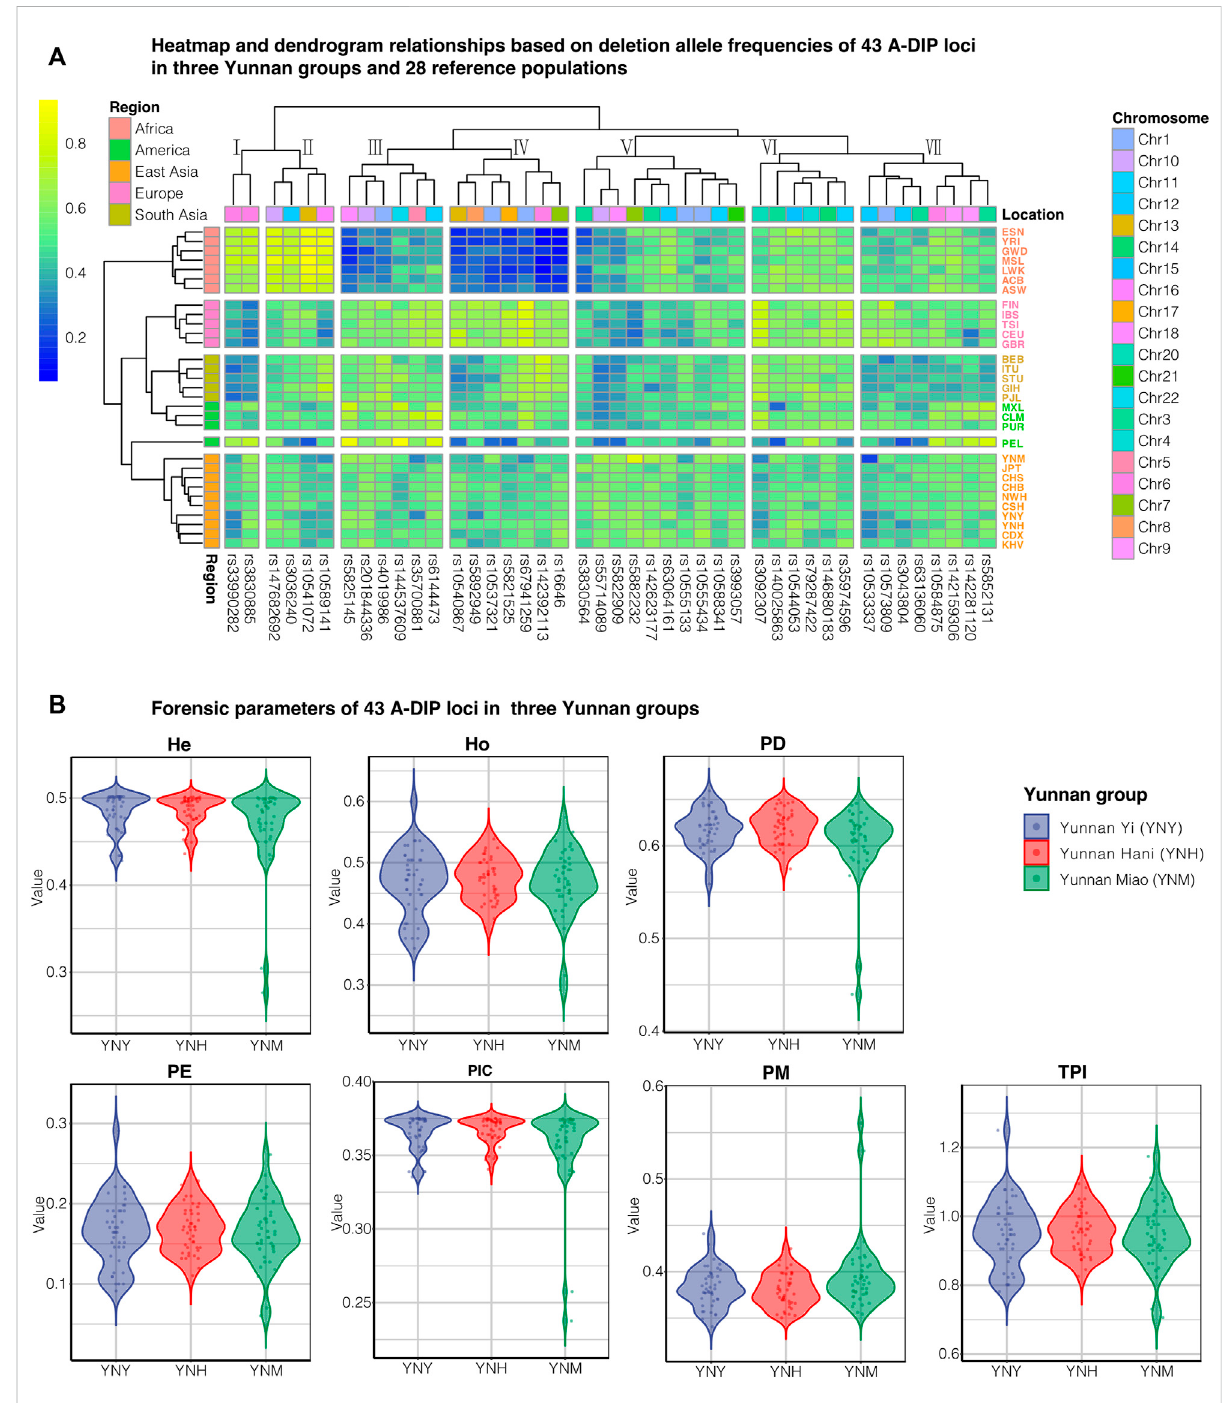
FIGURE 1 The deletion allelic frequency heatmap and forensic parameters of 43 A-DIPs in three Yunnan groups. (A) The deletion allelic frequency heatmap of 43A-DIP loci in Chinese Yunnan Yi, Hani, Miao groups and 28 reference populations; (B) The forensic parameters including He, Ho, PD, PE, PIC, PM and TPI of Chinese Yunnan Yi (YNY), Hani (YNH), and Miao (YNM) groups with blue, red, and green,